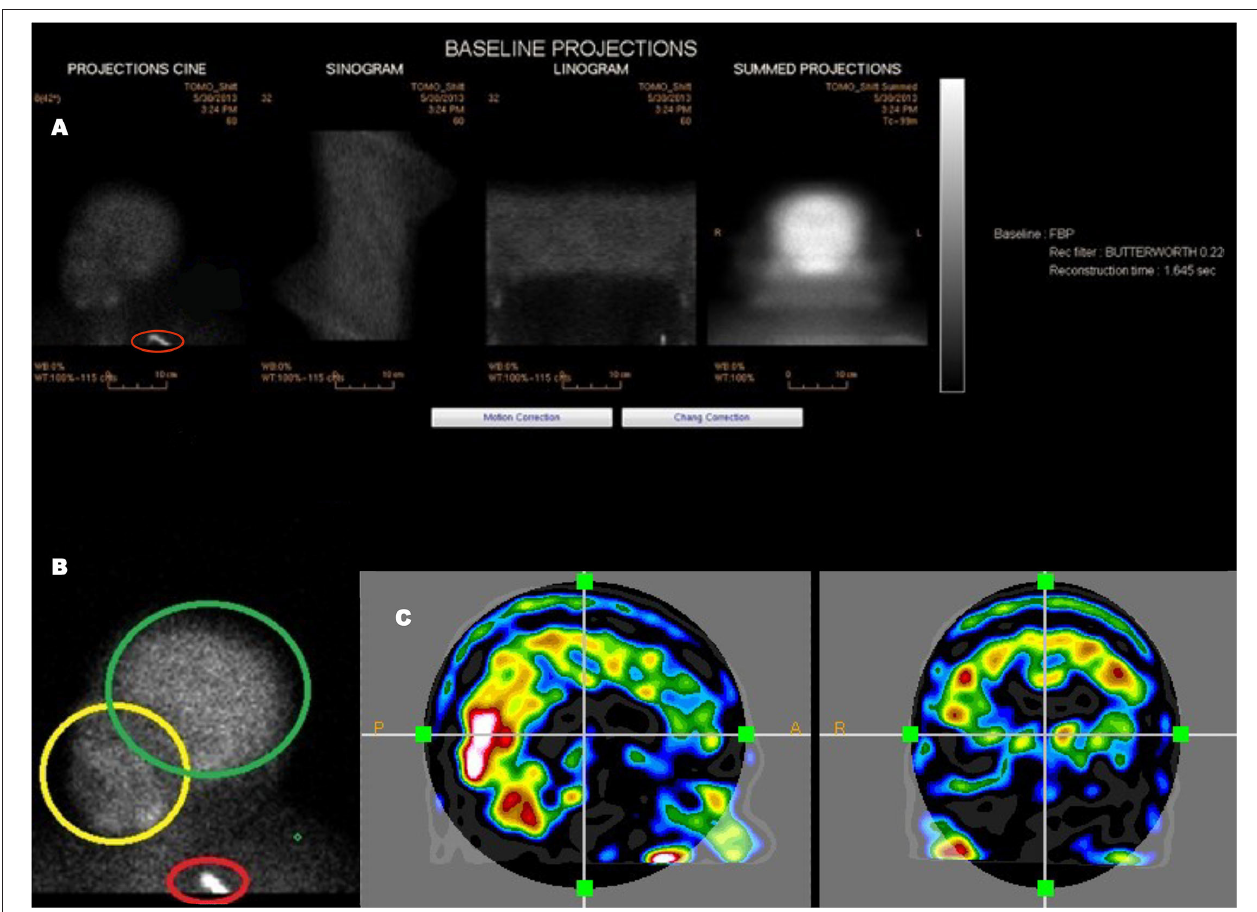
FIGURE 3 | An example of a poorly executed perfusion SPECT scan. (A) Projection cine, sinogram, linogram, and summed projections illustrate minimal motion artifact. However, multiple technical errors are evident. The detectors were positioned excessively far from the patient and the acquisition zoom was not correctly set which resulted in large areas of empty space above the head and inclusion down to at least the clavicle in the field of view. In addition, a spill artifact is seen at the level of the clavicle (red circle). The area occupied by the organ of interest—the brain—makes up a small part of the acquisition matrix, best demonstrated in the summed projections. (B) A close-up view of the projection cine illustrated relatively high uptake in the facial region (yellow circle) relative to the uptake in the brain (green circle) and the spill artifact (red circle) contributing significant number of counts which are unrelated to the brain. (C) Sagittal and coronal alignment images illustrating considerable uptake in the salivary glands and free technetium in the scalp. All of these extraneous counts will reduce the statistics available from the brain. Furthermore, the low spatial resolution of this poorly executed scan is clearly